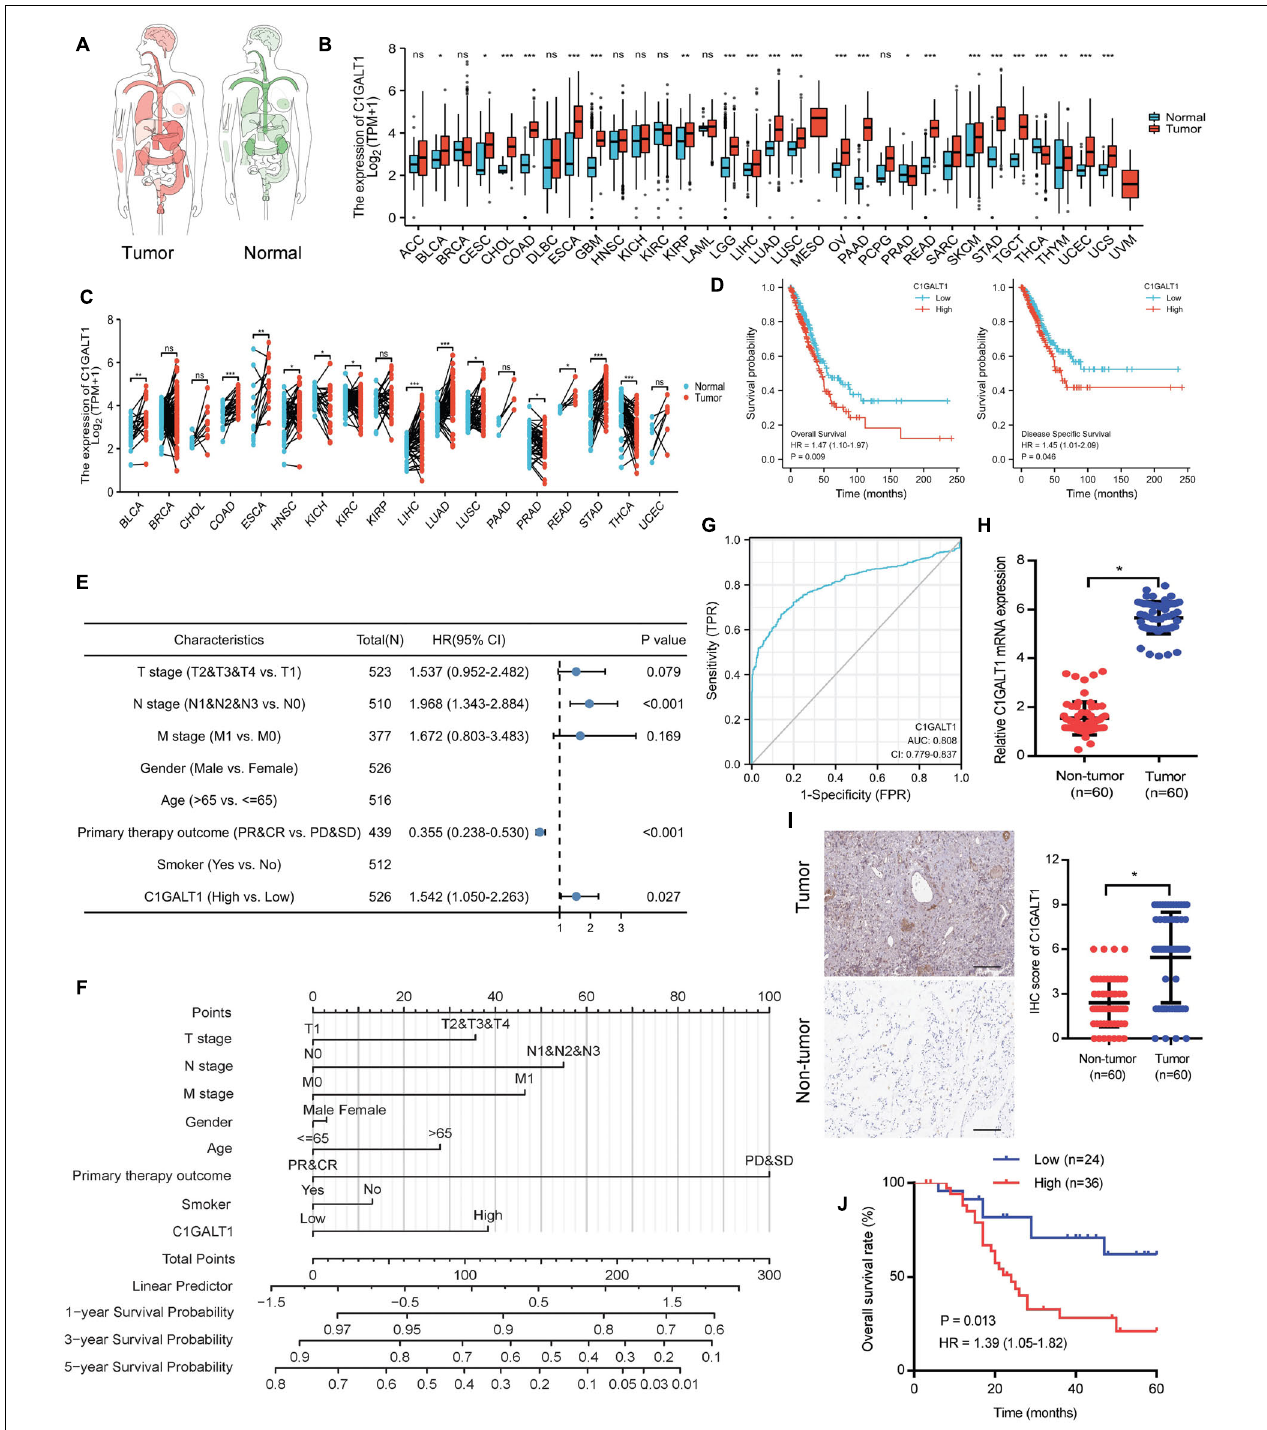
FIGURE 1 | C1GALT1 is overexpressed in LUAD and associated with poor prognosis. (A) Pan-cancer analysis of C1GALT1 using the TCGA database. (B) C1GALT1 expression in unpaired tumor and normal tissues from the TCGA database. (C) C1GALT1 expression profiles across all tumor samples and paired normal tissues in the TCGA database. (D) Kaplan-Meier curves for overall survival and disease-specific survival according to C1GALT1 expression in the TCGA-LUAD cohort. (E) Forest plot of multivariate Cox regression analysis. (F) Nomogram for predicting 1-, 3- and 5-year survival probability of LUAD patients. (G) ROC curve of C1GALT1 in LUAD. (H) Analysis of C1GALT1 expression in LUAD tissues and adjacent non-tumor tissues by qPCR. (I) IHC analysis of C1GALT1 expression in LUAD samples. Scale bar: 100 µ m. (J) Overall survival analysis of LUAD patients based on differential expression levels of C1GALT1. * p < 0.05; ** p < 0.01; *** p < 0.001; ns = not